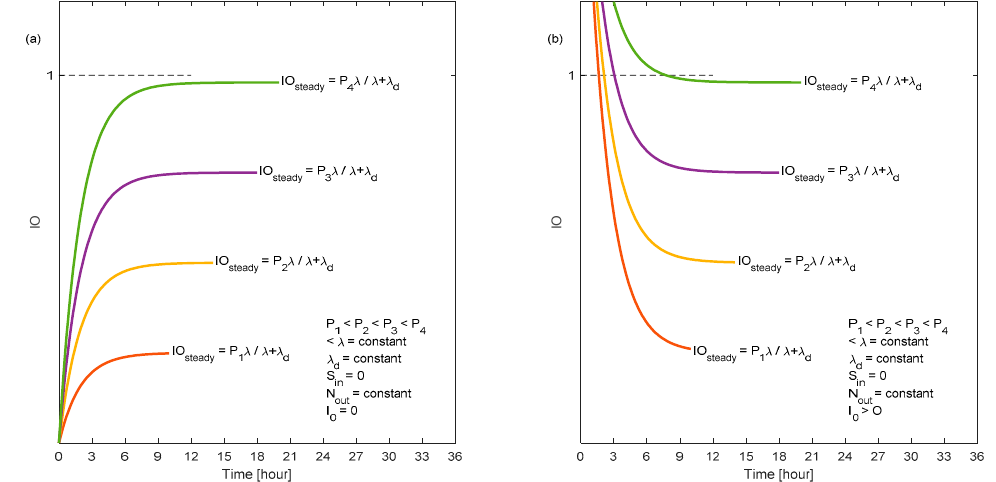
Figure A1. Role of the penetration factor ( P ) on the steady state indoor aerosol concentration (i.e., steady state indoor-to-outdoor concentration IO steady ) ( a ) when the initial indoor aerosol concentration I 0 = 0 and ( b ) when the initial indoor aerosol concentration is higher than that outdoors (i.e., I 0 > O). All other indoor aerosol parameters are held constant, as shown on the subplots.